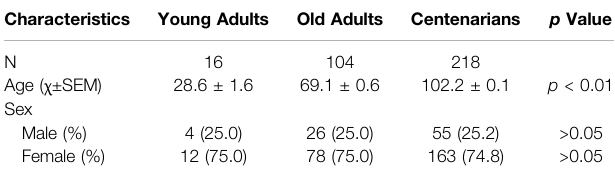
TABLE 1 | Characteristics of the study population. Characteristics